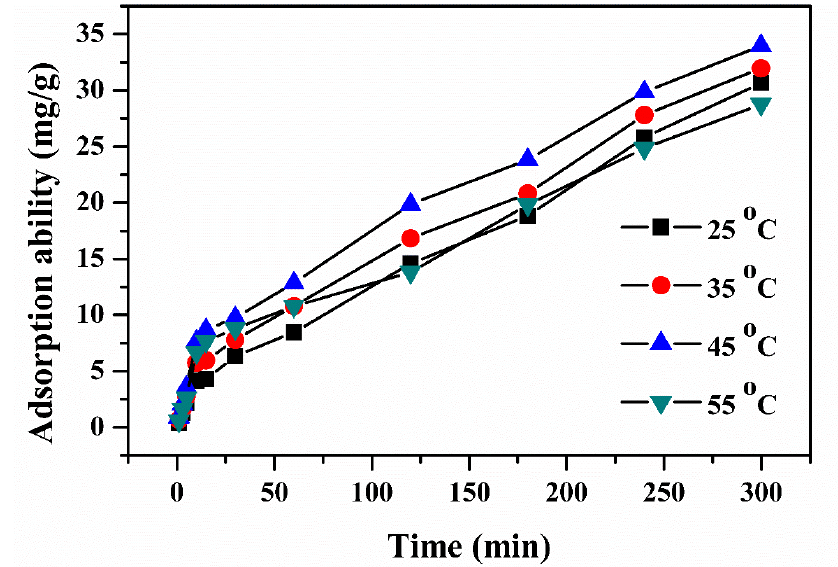
Figure 13. Effect of Pb(II) aqueous solution temperature for maximum adsorption of Pb(II) onto the OPB/PVA/MWCNTs hydrogel.